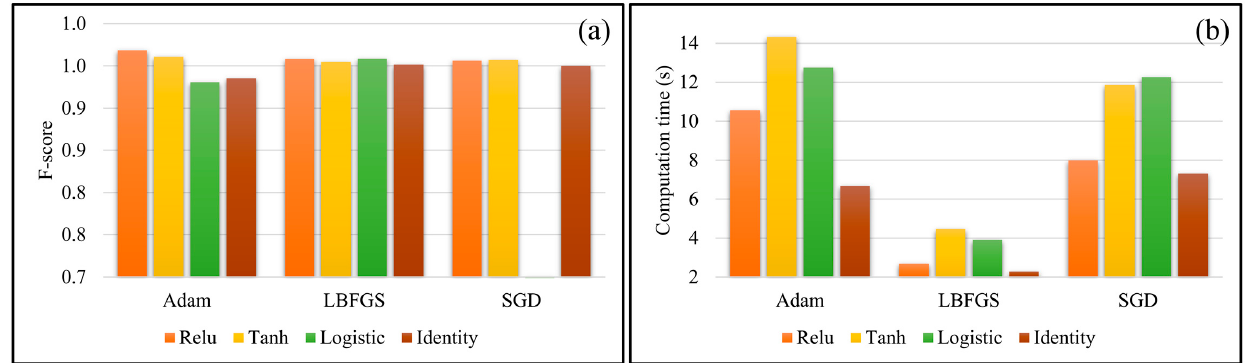
Figure 5. Obtained ( a ) F ‐ score values and ( b ) computation times of the training phase of the ANN algorithm using the best topologies adopted from Figure 4 for the three learning algorithms based on four different activation functions.